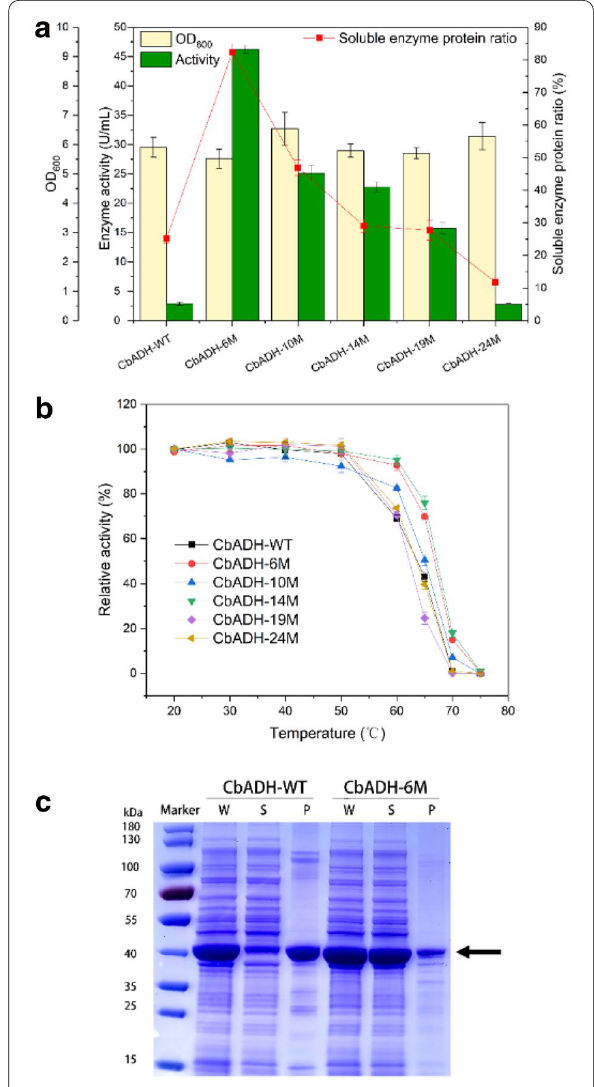
Fig. 4 Characterization of CbADH mutants compared with the wild type. a Enzyme activity in shake-flask fermentation at 25 ℃ with 0.5 mM IPTG dosage. The green column represents the crude enzyme activity, while the beige column represents OD 600 . The red square represents the proportion of soluble protein to total protein. b Thermal stability of the wild CbADH and the mutants. c SDS-PAGE analysis of protein expression of the wild-type CbADH-WT and mutant CbADH-6M: Lane M: molecular weight marker; Lane W: whole cell protein; Lane S: supernatant; Lane P: